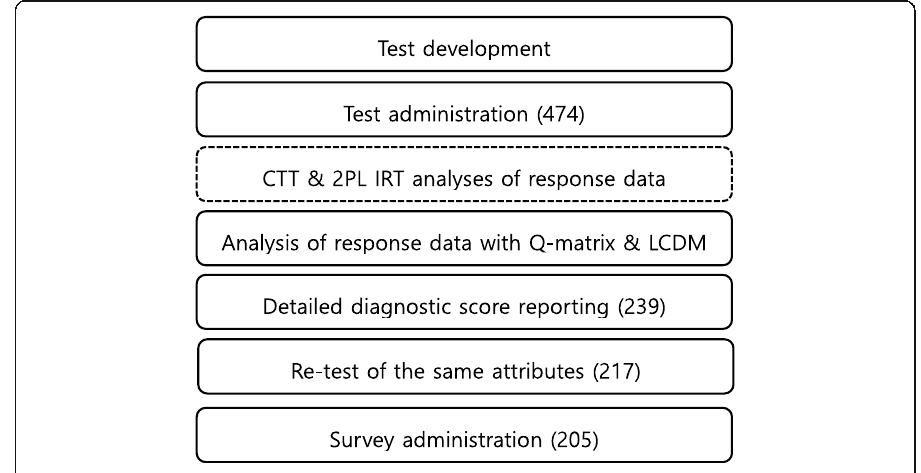
Fig. 1 Steps of the research